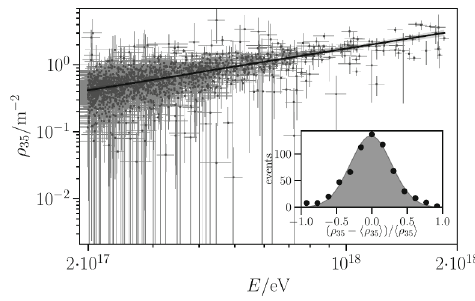
Figure 7. Experimental muon density estimator ρ 35 (dots) as a function of the reconstructed energy, and a single power-law fit (line). (Inset) The distribution of the normalized residuals.